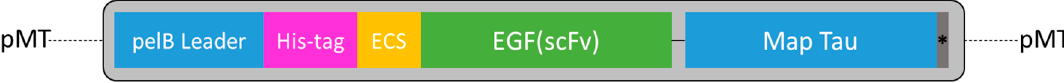
Figure 2. Schematic representation of the expression cassette for the recombinant epidermal growth factor (EGF)–MAP human cytolytic fusion protein. The open reading frame (ORF) was expressed in E. coli BL21(DE3) using protocol for periplasmic stress expression in the presence of compatible solutes and includes an N-terminal pectate lyase B (pelB) leader sequence from Erwinia carotovora which directs the fusion protein to the periplasmic space, a His 10 tag to facilitate purification, and an enterokinase cleavage site (ECS) to allow proteolytic separation of the fusion construct from the upstream production sequence. * = C-terminal nuclear localization signal sequence (NLS).